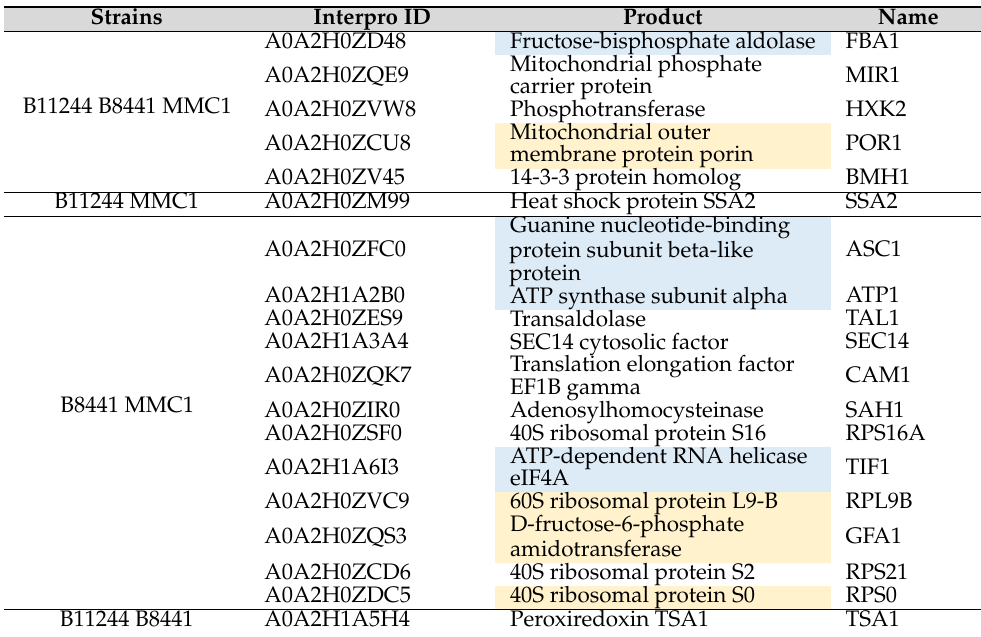
Table 2. Differentially expressed proteins identified in C. auris EVs after caspofungin treatment comparing different